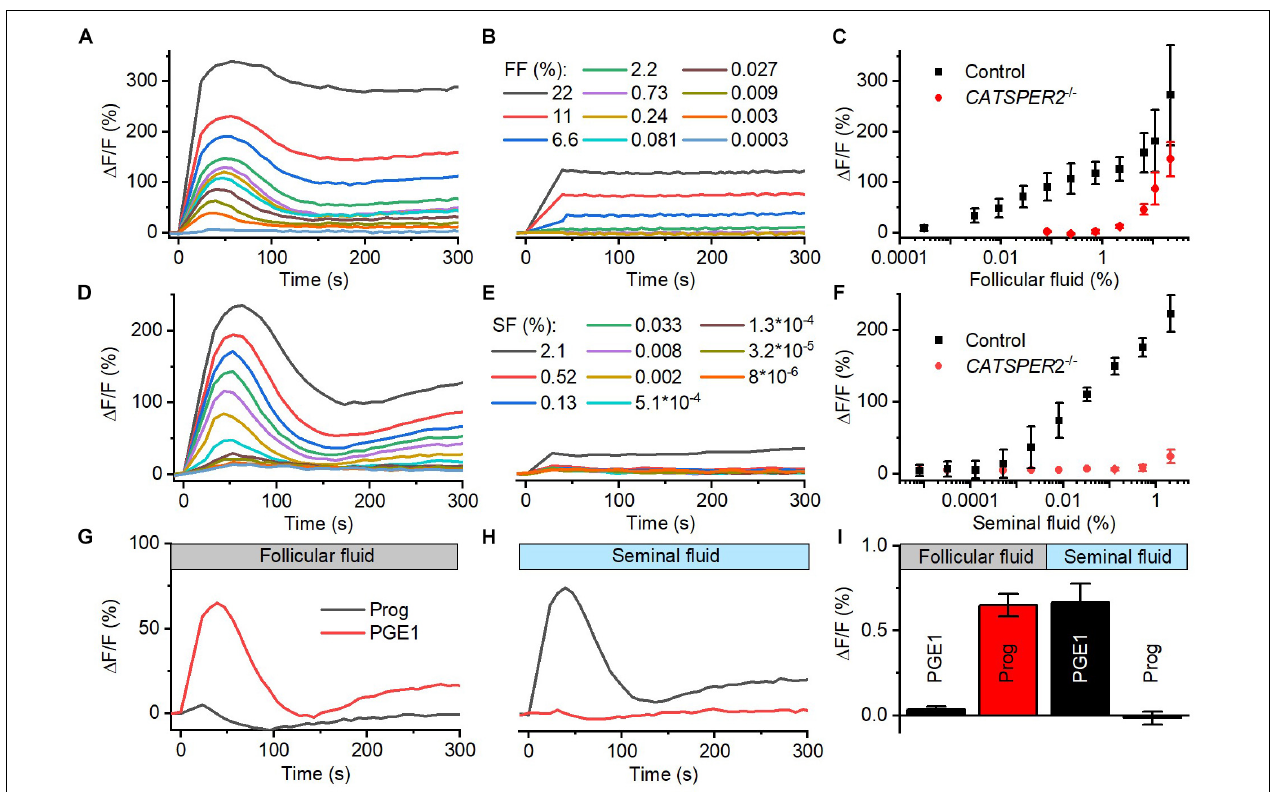
FIGURE 1 | Follicular and seminal fluid-evoked Ca 2 + signals in human sperm. (A) Representative Ca 2 + signals evoked by dilute solutions of follicular fluid (FF); the final FF concentration is indicated as volume/volume percentage. [Ca 2 + ] i was monitored in control sperm from donors loaded with a fluorescent Ca 2 + indicator, using a fluorescence plate reader. (cid:49) F/F (%) indicates the percent change in fluorescence ( (cid:49) F) with respect to the mean basal fluorescence (F) before application (and subsequent continuous presence) of FF at t = 0. (B) Representative FF-evoked Ca 2 + signals in sperm from patients deficient for the CATSPER2 gene ( CATSPER2 - / - ), lacking functional CatSper channels. (C) Concentration–response relationship for the mean ( ± SD) maximal signal amplitudes evoked by FF in control and CATSPER2 - / - sperm ( n = 3). (D) Representative Ca 2 + signals evoked by dilute solutions of seminal fluid (SF) in control (D) and CATSPER2 - / - (E) sperm. (F) Concentration–response relationship for the mean ( ± SD) maximal signal amplitudes ( n = 3). (G) Representative progesterone- and PGE 1 -evoked Ca 2 + signal in control sperm preincubated in 1% FF or (H) 0.5% SF; progesterone or PGE 1 was applied at t = 0. (I) Mean ( ± SD) maximal amplitude of progesterone- and PGE 1 -evoked Ca 2 + signals in control sperm preincubated in 1% FF or 0.5% SF ( n =